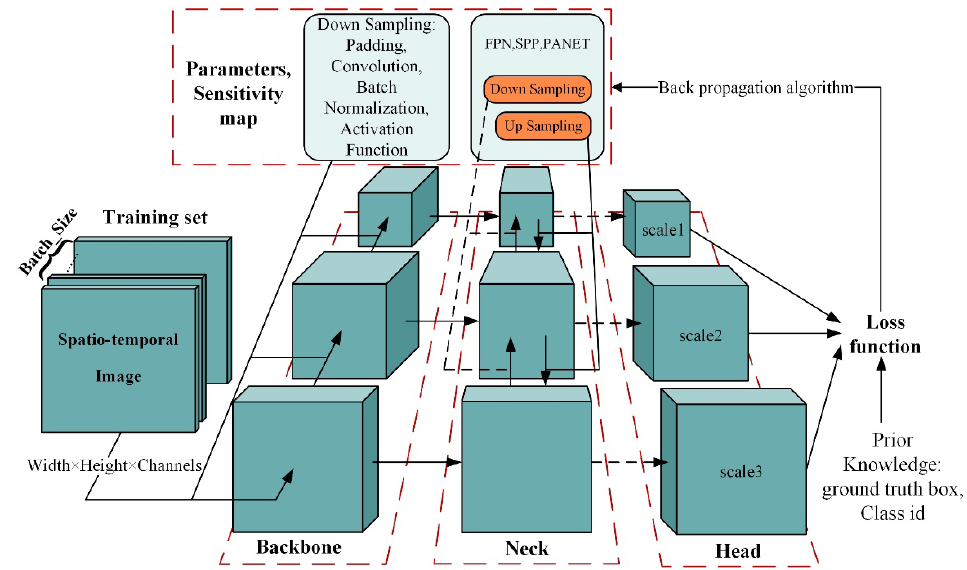
Figure 5. YOLO target detection meta-architecture training process.